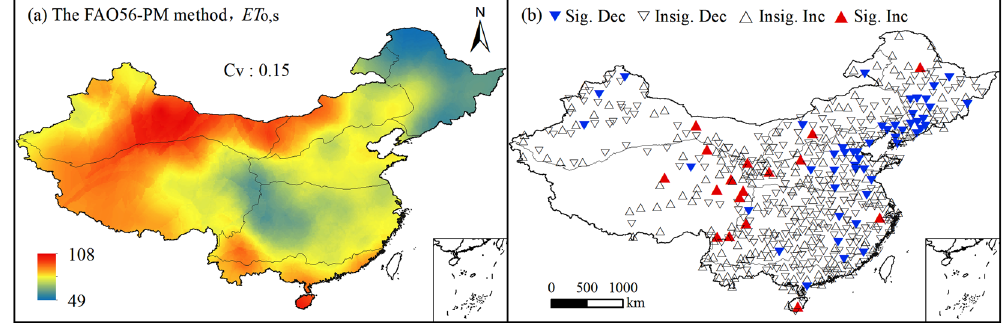
Figure 3. Spatial distribution of multi-year mean monthly ET o,s and the annual ET o,s trends over 1961–2013 at the 552 sites in mainland China. (ArcGIS 10.2, http://map.baidu.com, Lingling Peng).